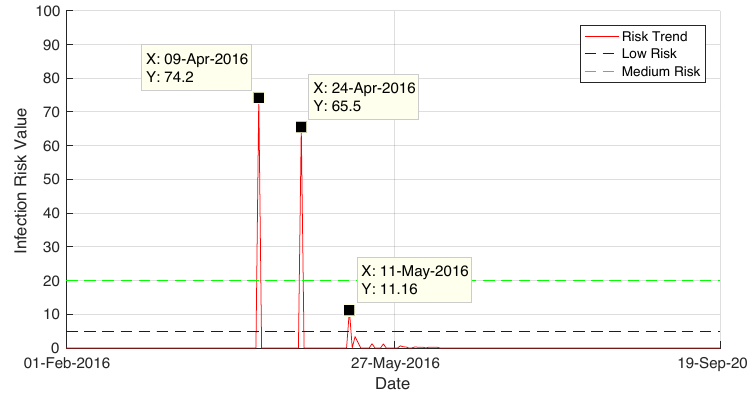
Figure 14. Risk of infection evaluated at San Michele without leaf wetness evaluation. For an infection model that does not use the MLP for leaf wetness extension, this risk coincides with the one for the San Michele External